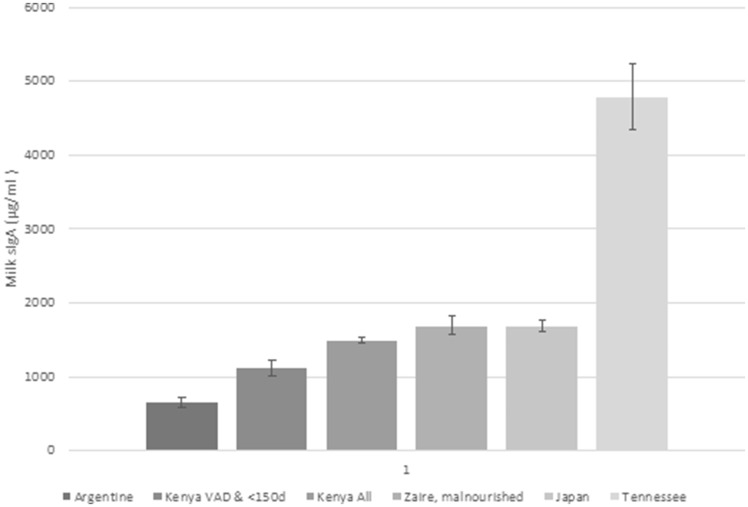
Concentrations of sIgA in mothers’ milk in northern Kenya along with published values from select populations. Kenyan values are shown in two bars: one for our sub-sample of VAD Ariaal mothers with young infants (<150 days), and the other for all of our participating mothers. The graph shows that, regardless of VA status, Ariaal mothers’ milk sIgA concentrations tended to occupy the lower range of reported values from several populations of differing levels/types of nutritional stress. Among the Ariaal, VAD mothers with young infants had significantly lower sIgA than the overall mean, but higher than the value reported from the Toba of northern Argentine. sIgA, secretory immunoglobulin A; VAD vitamin A deficiency